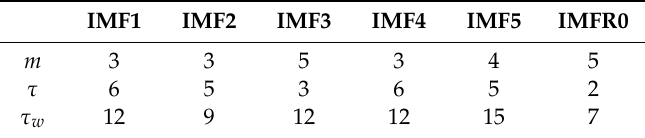
Table 3. Phase space reconstruction parameters for each